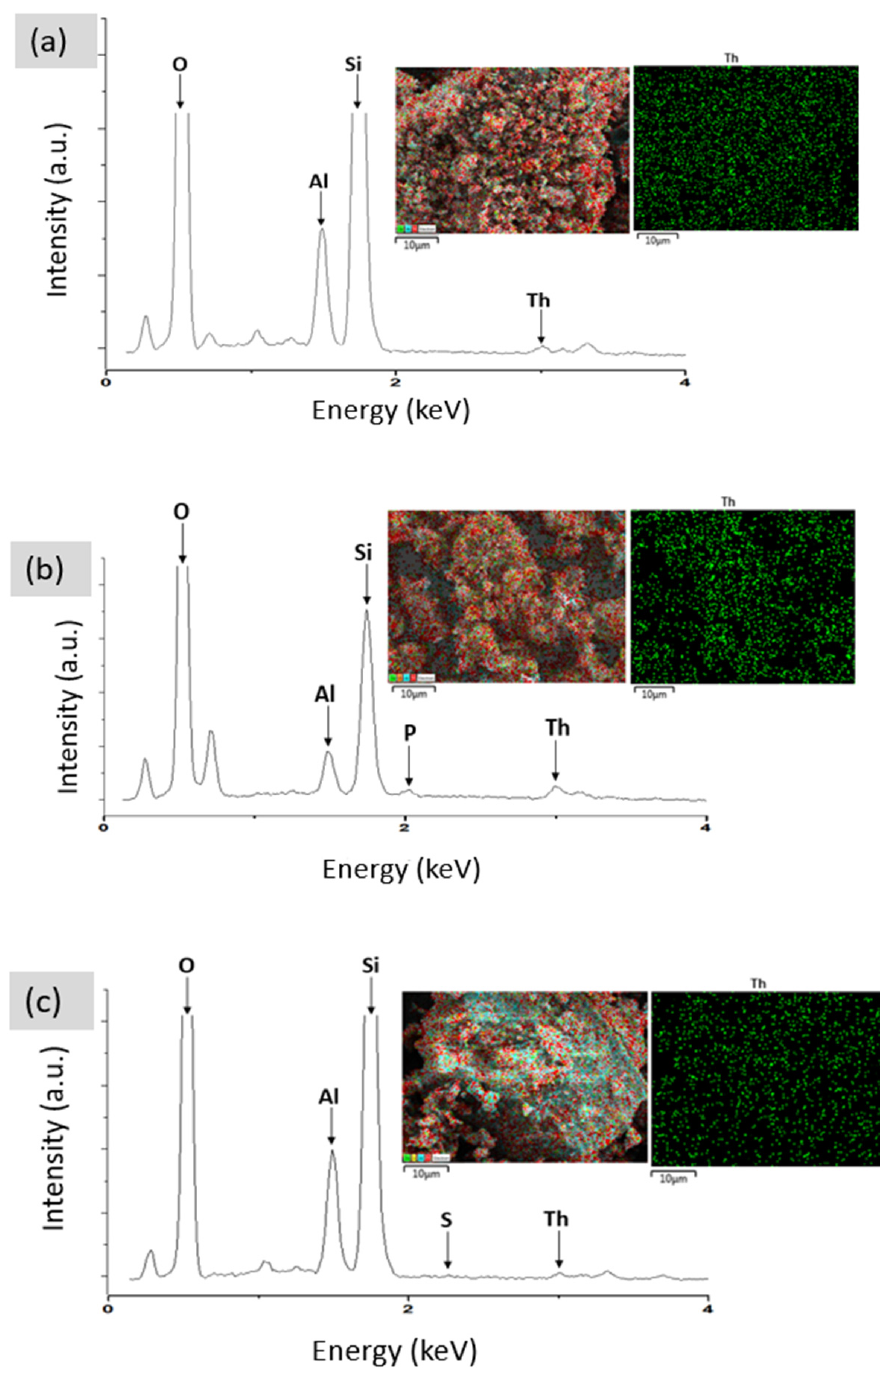
Figure 17. EDX analysis showing the EDX spectrum and dot mapping of ( a ) NZ, ( b ) PZ, and ( c ) SZ after the adsorption of thorium, at a magnification of 10,000 ×